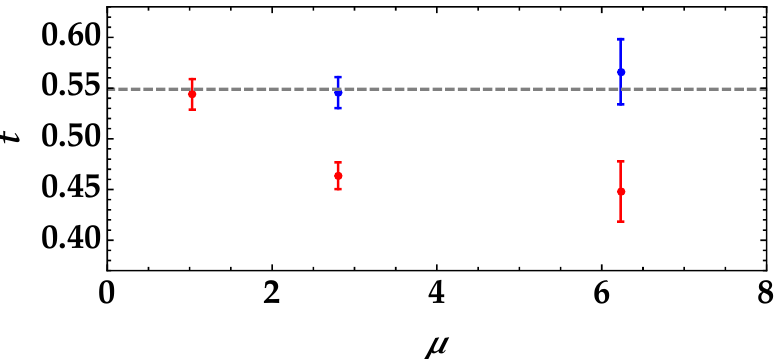
Figure 6. Values of t obtained fitting the data according to Equation (6) (red dots) and Equation (8) (blue dots) as a function of the number of modes. The gray dashed line represents the expected value t = 0.550.